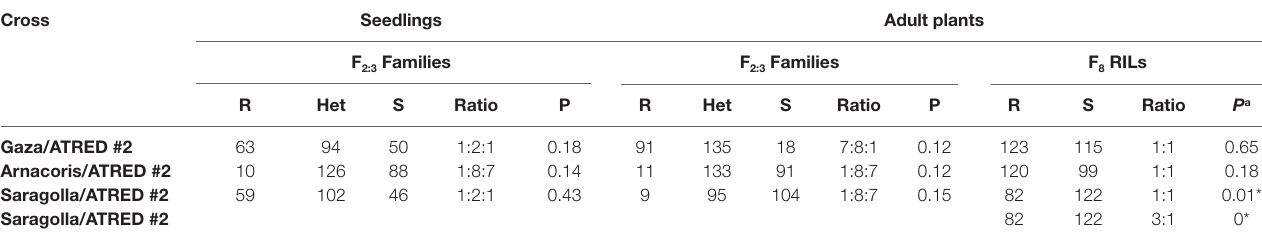
TABLE 1 | Segregation ratios of the F 2:3 and F 8 progenies from three crosses of durum wheat lines evaluated for leaf rust resistance to race BBG/BP of P. triticina , at the seedling and adult plant stages. Cross